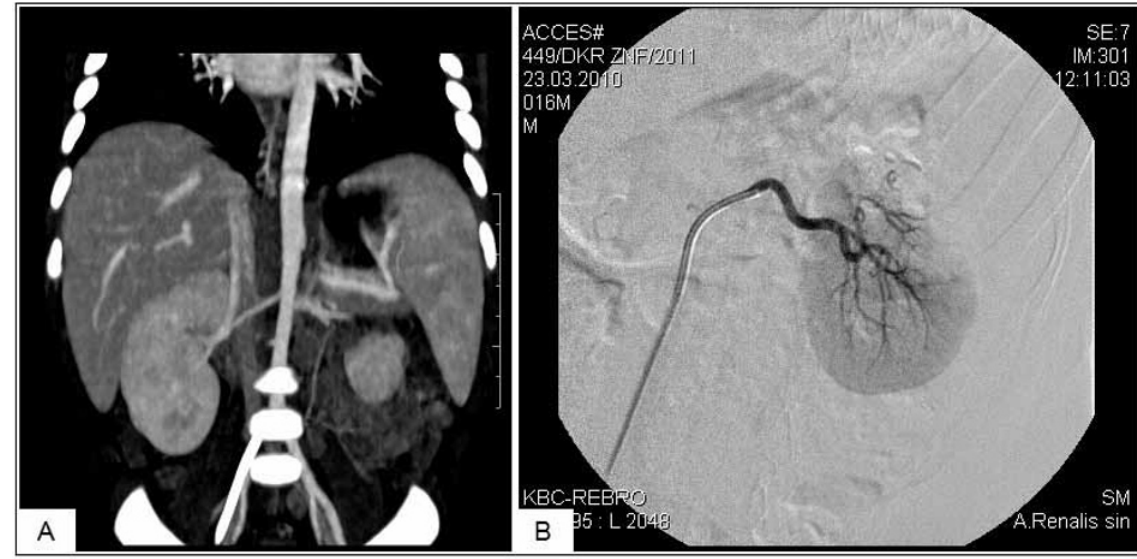
Figure 1. MSCT renal angiography with vascular anomaly (A) and abdominal aortal digital subtraction angiography (B) of the left